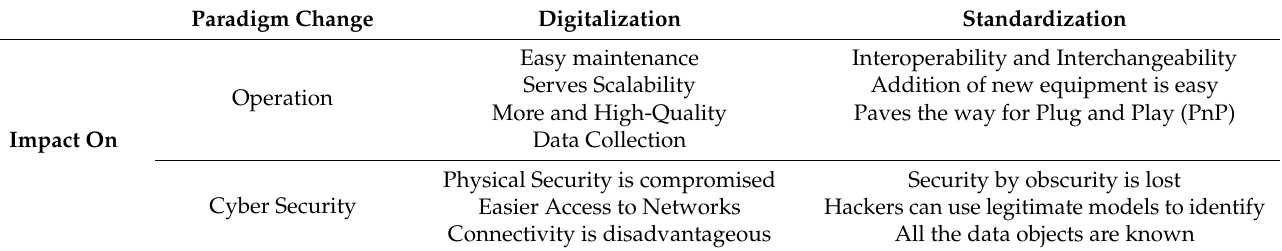
Table 2. Paradigm changes in power